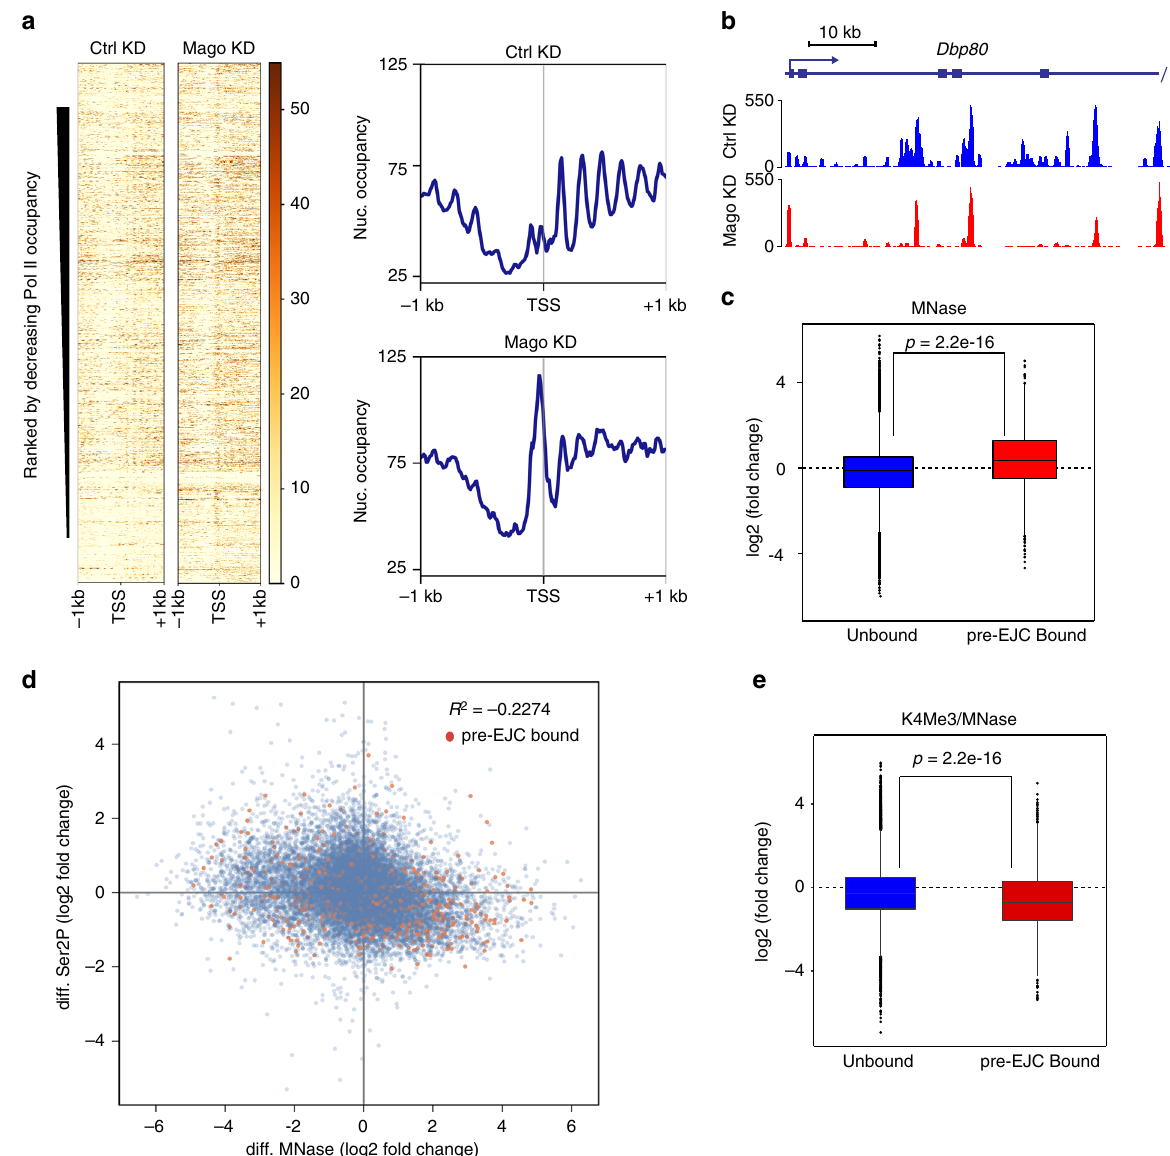
Fig. 3 Mago controls chromatin accessibility. a Heatmaps of nucleosomal occupancy from MNase-seq experiments performed in biological duplicates from S2R + cells in control or Mago knockdown conditions centered at the TSS in a ±1 Kb window. Rows indicate all the genes bound by Pol II and are sorted by decreasing Pol II occupancy. The color labels to the right indicate the levels of nucleosomal occupancy. Composite metagene pro fi les are also shown, with nucleosomal occupancy level on Y -axis and genomic coordinates on X -axis. b Genome browser view of averaged enrichment MNase-seq data from two independent biological duplicates in S2R + cells treated with control or Mago double stranded RNA. The example shown here is Dbp80 gene, a well-de fi ned pre-EJC target. c Log2 fold changes in nucleosomal occupancy at the TSS (250 bp upstream and downstream of TSS) after control and Mago knockdowns. The changes were separated according to pre-EJC binding and a two-sample t -test was performed. d Scatterplot between changes in nucleosome and Ser2P occupancy after either control or Mago knockdown. Pre-EJC-bound promoters are highlighted by orange color. A mild negative correlation, as shown in the indicated pearson coef fi cient of correlation, between nucleosome and Ser2P occupancies was found. e Log2 fold changes in K4Me3 levels normalized to the nucleosomal occupancy (MNase data) at the TSS (250 bp upstream and downstream of TSS), after control and Mago knockdowns. The changes were separated according to pre-EJC binding and a two-sample t -test was